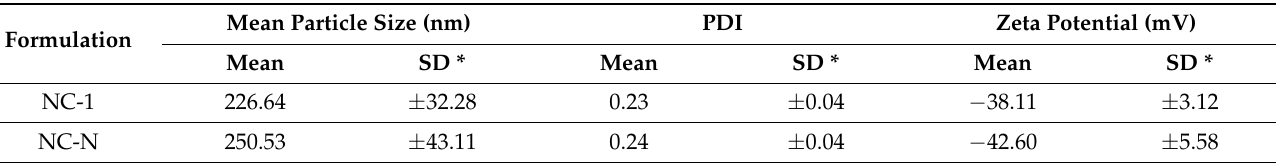
Table 2. Mean diameter, polydispersity index (PDI), and zeta potential of the TAC-loaded (NC-1) and non-loaded (NC- N)